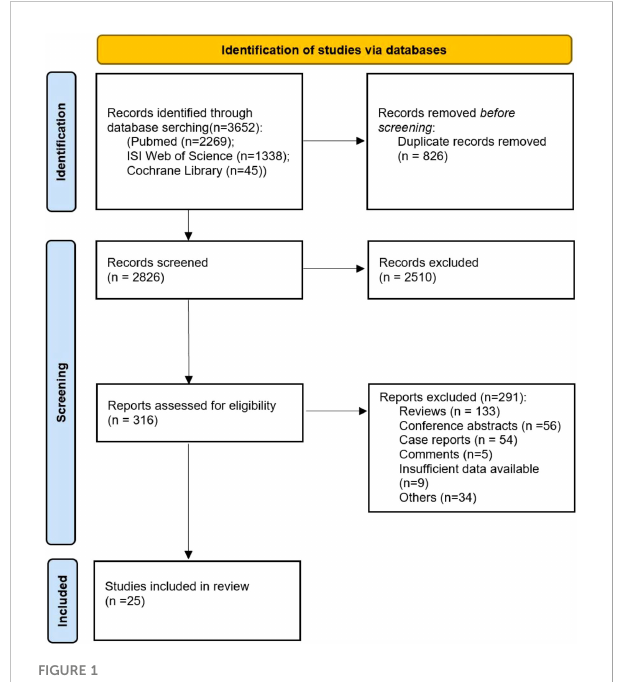
FIGURE 1 Flow diagram of included and excluded